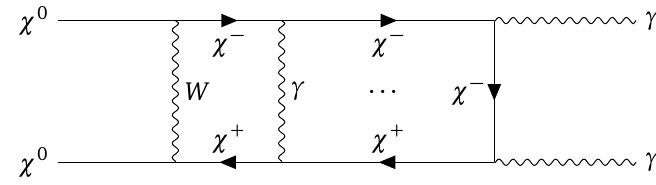
Figure 9: Example of annihilation of a supersymmetric wino χ 0 to photons, via a long-range potential mediated by exchange of weak gauge